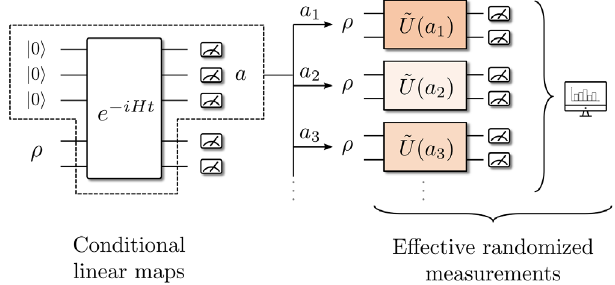
FIG. 2. Illustration of the basic working principle of our protocol. Quench evolving the extended system by natural time evolution e − iHt followed by measuring the ancillas is effectively ˜ U equivalent to applying a random linear map ð a Þ on the system ˜ U described by the state ρ . The linear map ð a Þ is determined by the random outcome a that the ancillas collapse to, which occurs with probability P . This protocol therefore implements random- a ized rotations on ρ and realizes effective randomized measure-